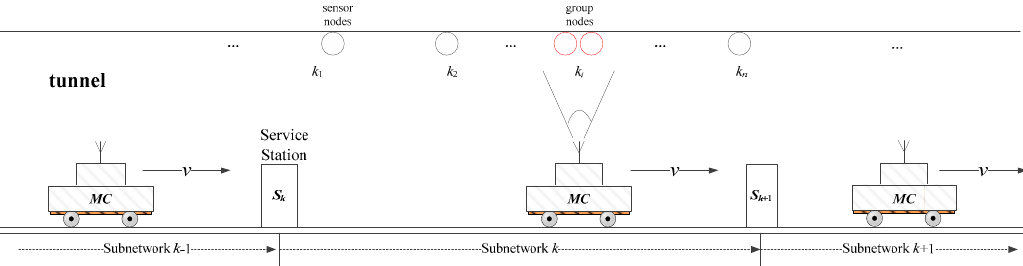
Figure 1. A map of a wireless rechargeable sensor networks (WRSNs).